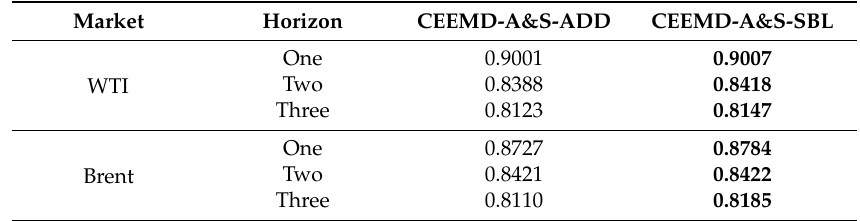
Table 14. The Dstat values of different prediction models on WTI and Brent crude oil